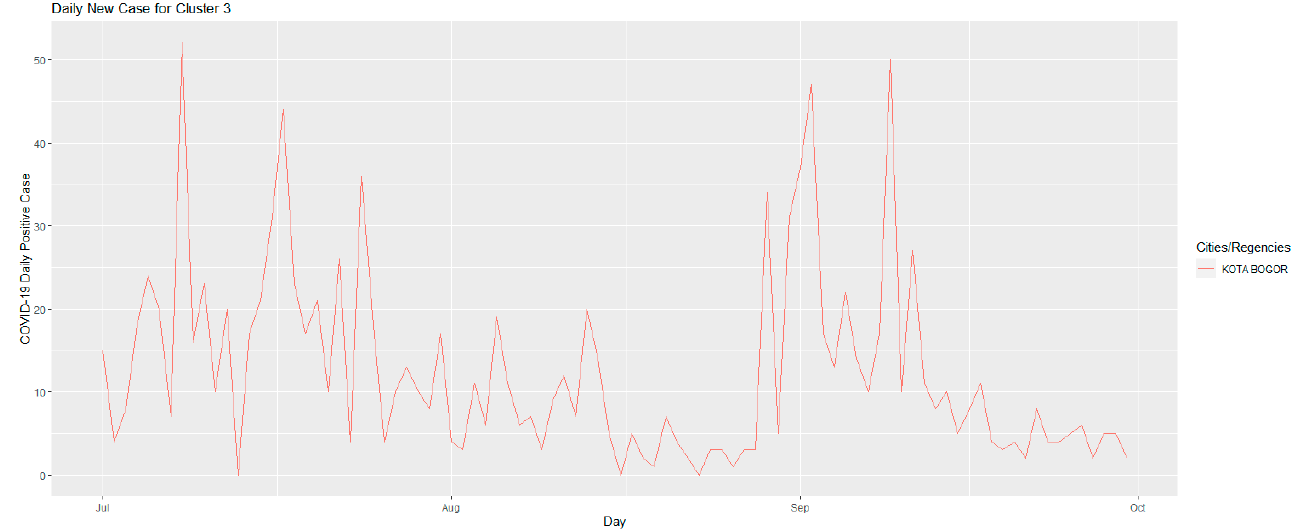
Figure 6. Daily positive cases of COVID-19 in Cluster 3 for the first period.